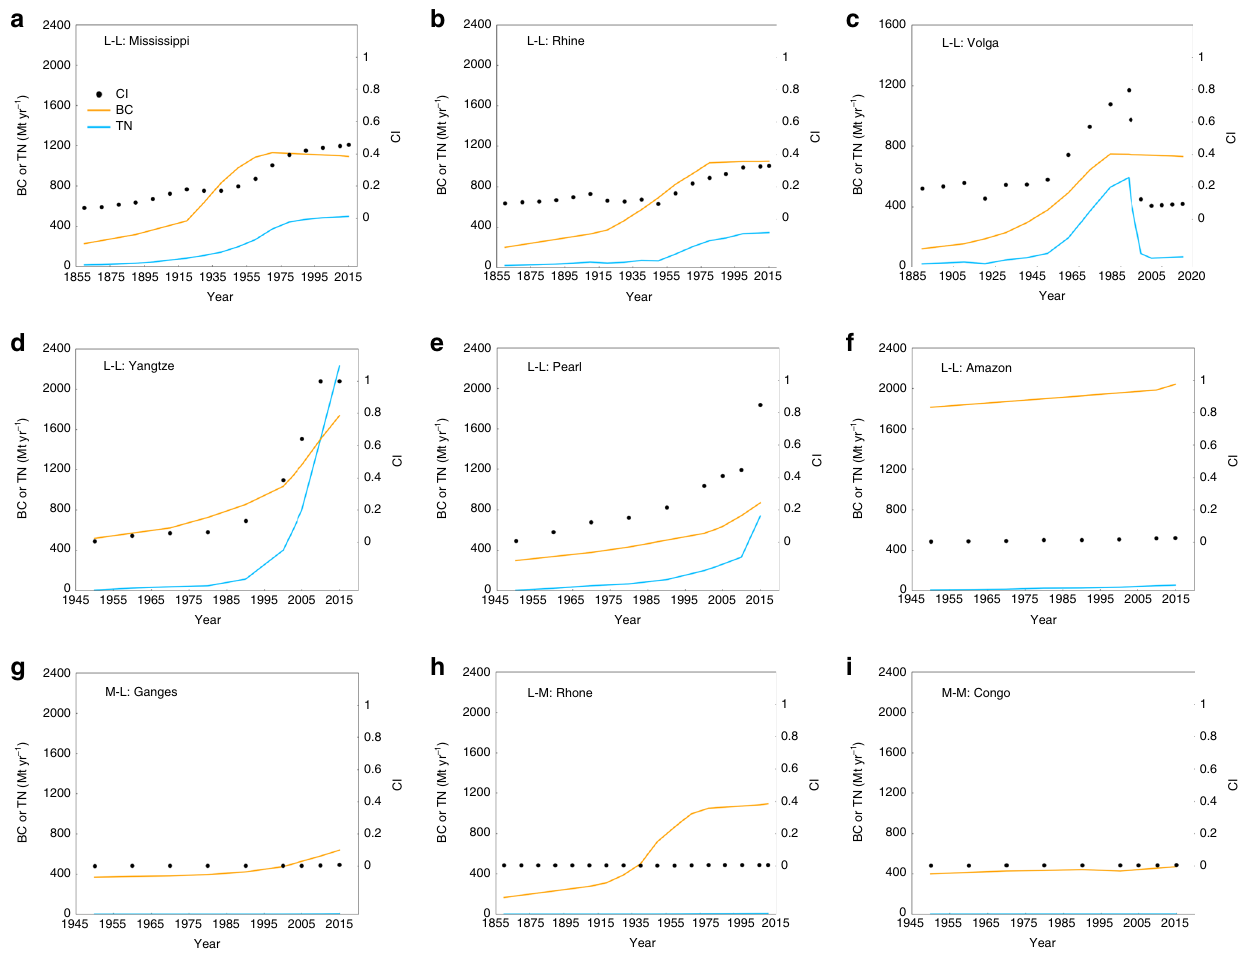
Fig. 3 Development paths of nine representative Golden Inland Waterways. In each of the nine sub-graphs, dynamic changes are shown of bearing capacity (BC, Mt yr − 1 ), transport need (TN, expressed as actual freight transport volume, Mt yr − 1 ), and consistency index (CI = 0 – 1, de fi ned as the ratio of TN to BC). These include ( a – f ) the L-L pattern represented by Mississippi, Rhine, Volga, Yangtze, Pearl, and Amazon, respectively; ( g ) the M-L pattern represented by Ganges; ( h ) the L-M pattern by Rhone; and ( i ) the M-M patter by Congo. Blue and yellow lines denote the evolution of TN and BC, respectively, whereas black dots indicate the trend of CI. Source data are provided as a Source Data fi